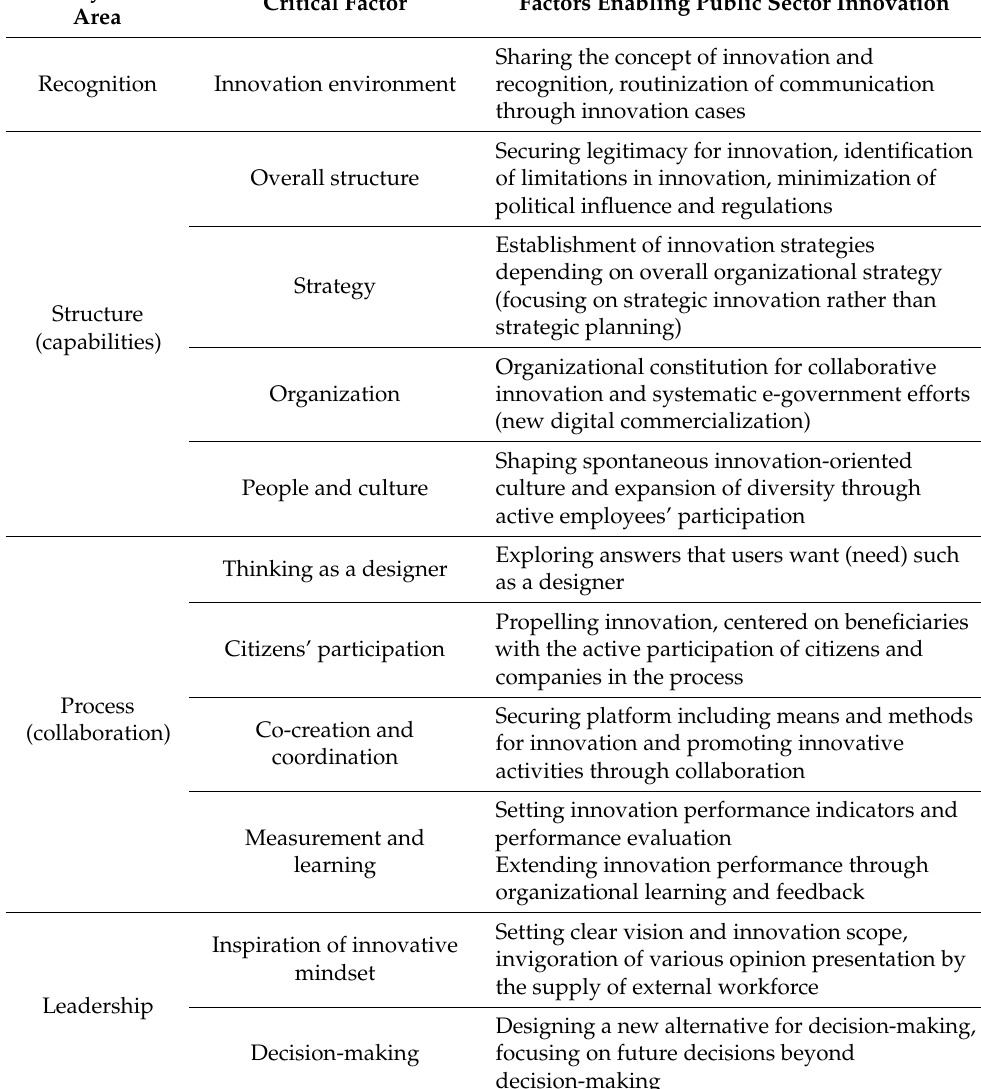
Table 2. Critical factors of public sector innovation